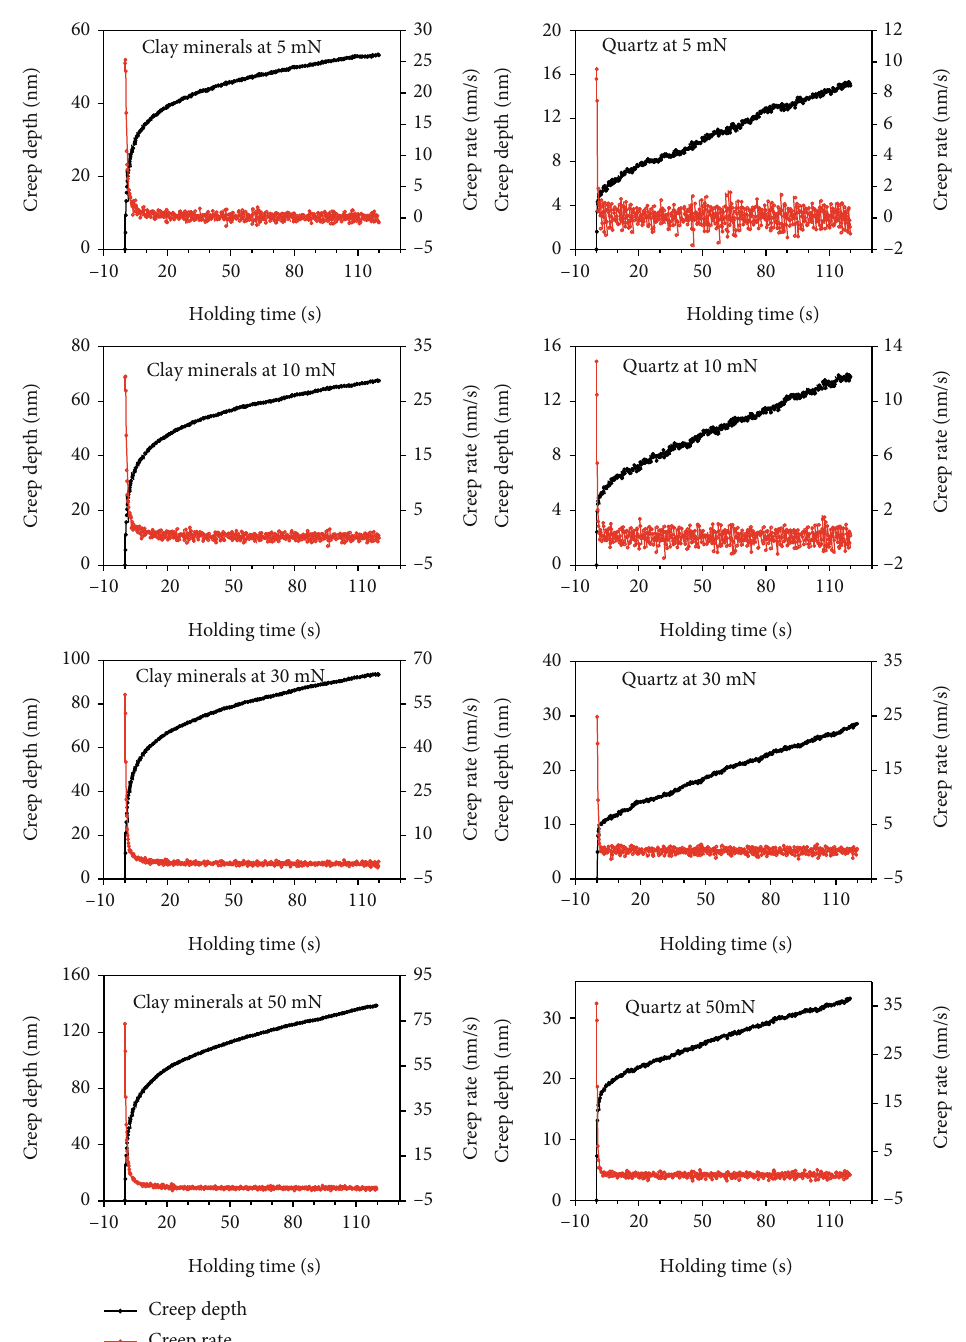
Figure 5: Examples of creep rate and depth for quartz and clay minerals at di ff erent peak